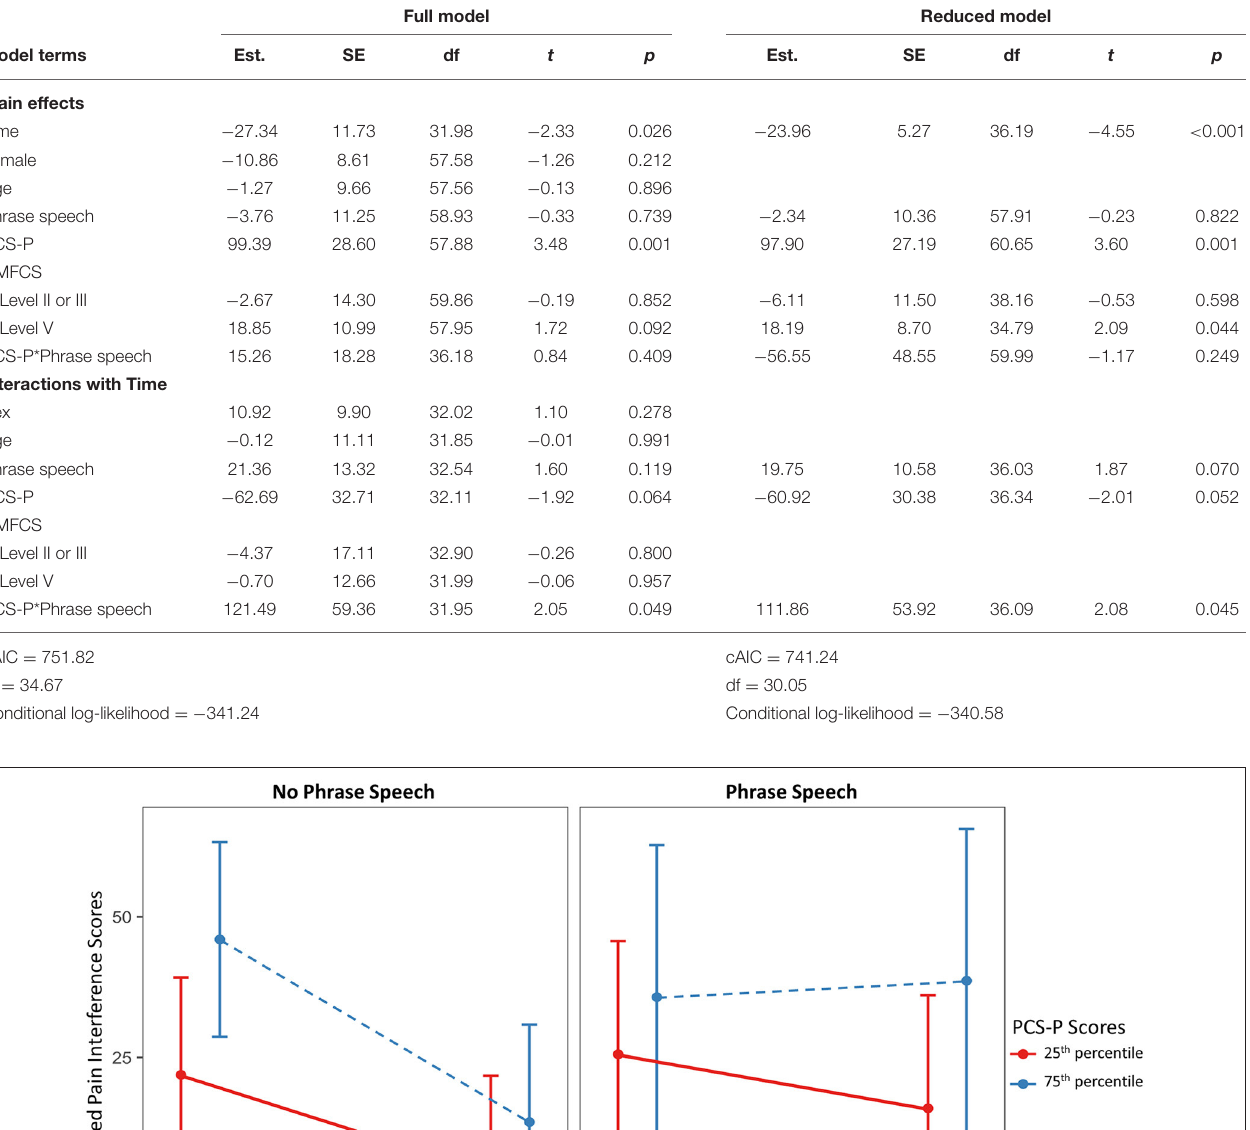
pain, this relationship is likely bidirectional, with higher child pain leading to greater parental catastrophizing, which in turn, leads parents to restrict activities or engage in other protective behaviors that ultimately increase child disability and